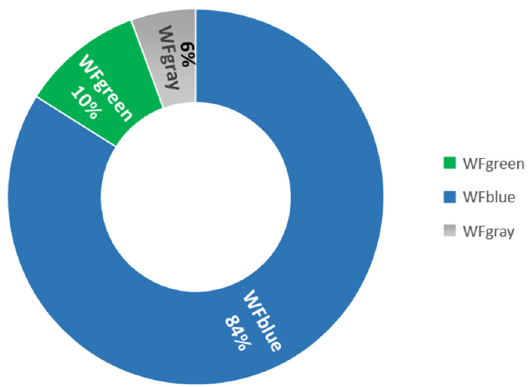
Figure 3. Three different WF components in cotton production.